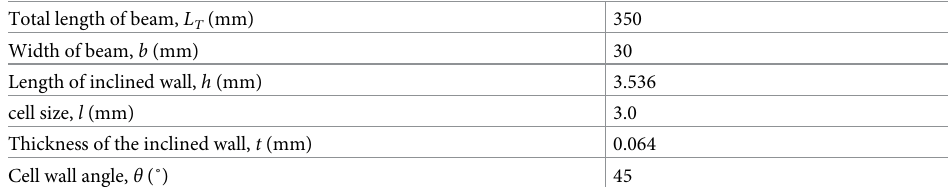
Table 1. Dimensions of the SHC beam and its aluminum honeycomb unit cell.